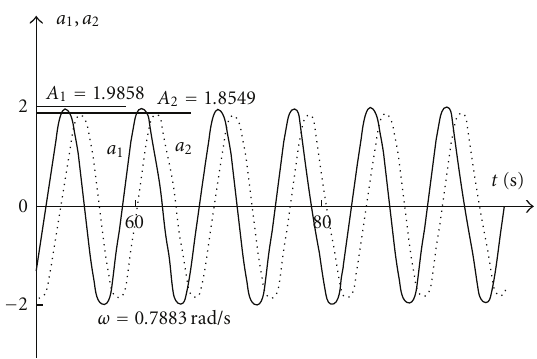
Figure 4: Time responses of the illustrating